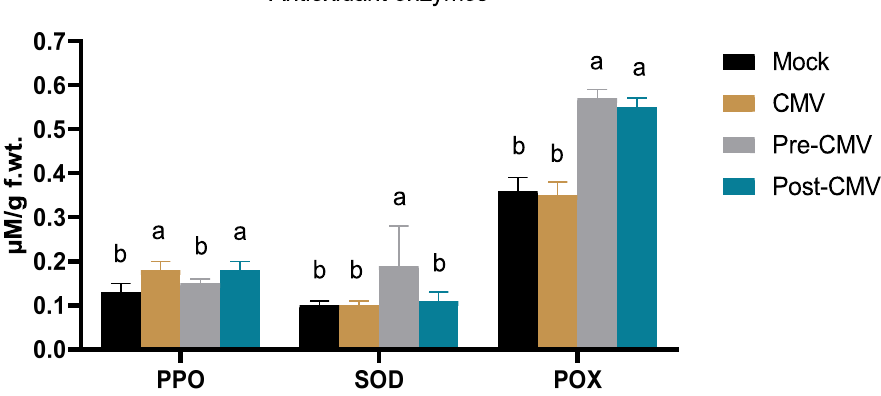
Figure 8. The impact of Ag-NPs foliar application on three antioxidant enzymes (PPO, SOD, and POX) in squash plants. Mock: plants inoculated with viral inoculation buffer; CMV: plants mechanically inoculated with CMV; Pre-CMV: plants treated with Ag-NPs, 24 h before CMV inoculation; Post-CMV: plants treated with Ag-NPs, 24 h after CMV inoculation. Statistically, there is no variation between the means of the columns that share the same letter.